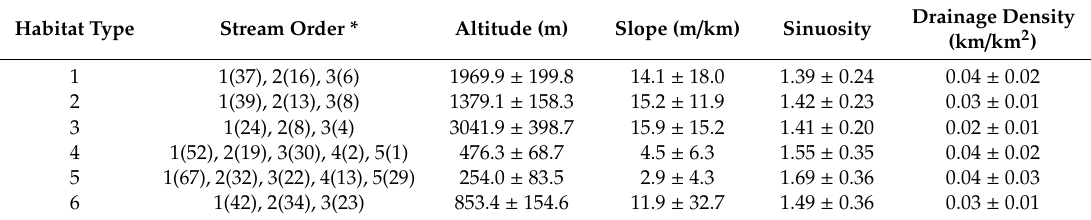
Drainage Density (km / km 2 )